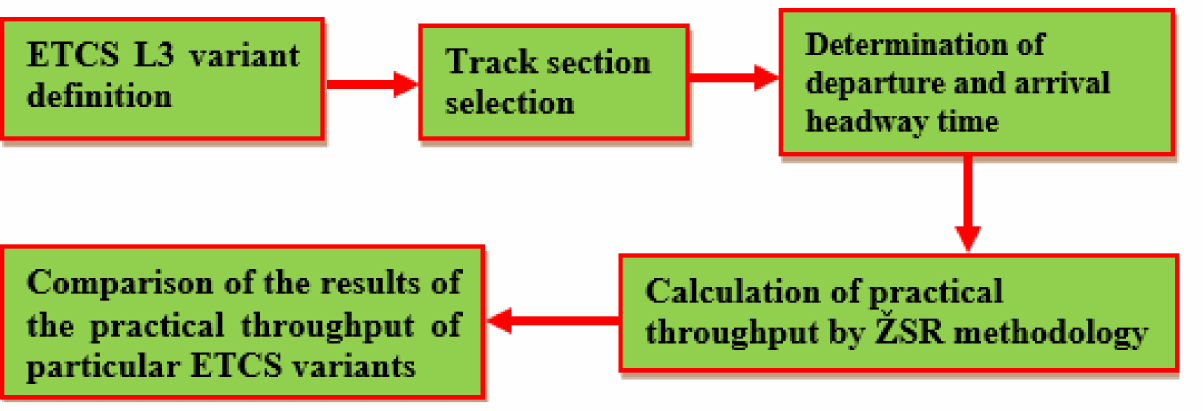
Figure 3. Heuristic procedure for solving the problem of line capacity